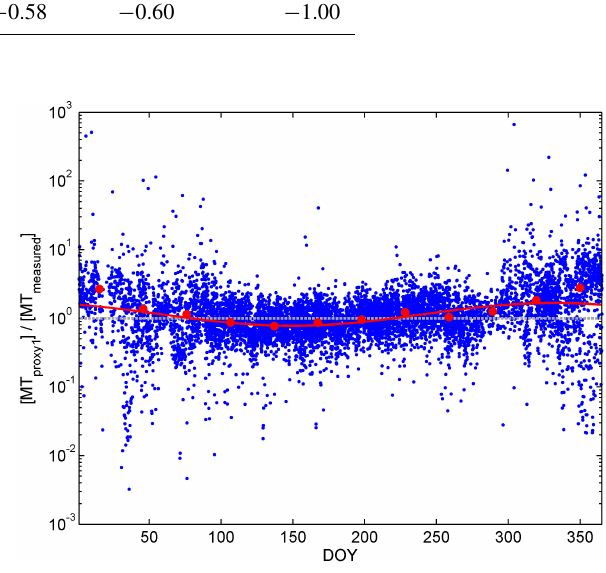
Figure 3. The ratio between MT proxy1 and the measured monoter- pene concentration as a function of day of year (DOY). The red circles show the monthly medians of the ratio, and the red line de- picts the function fitted to the ratio. The gray dashed line shows the ratio of